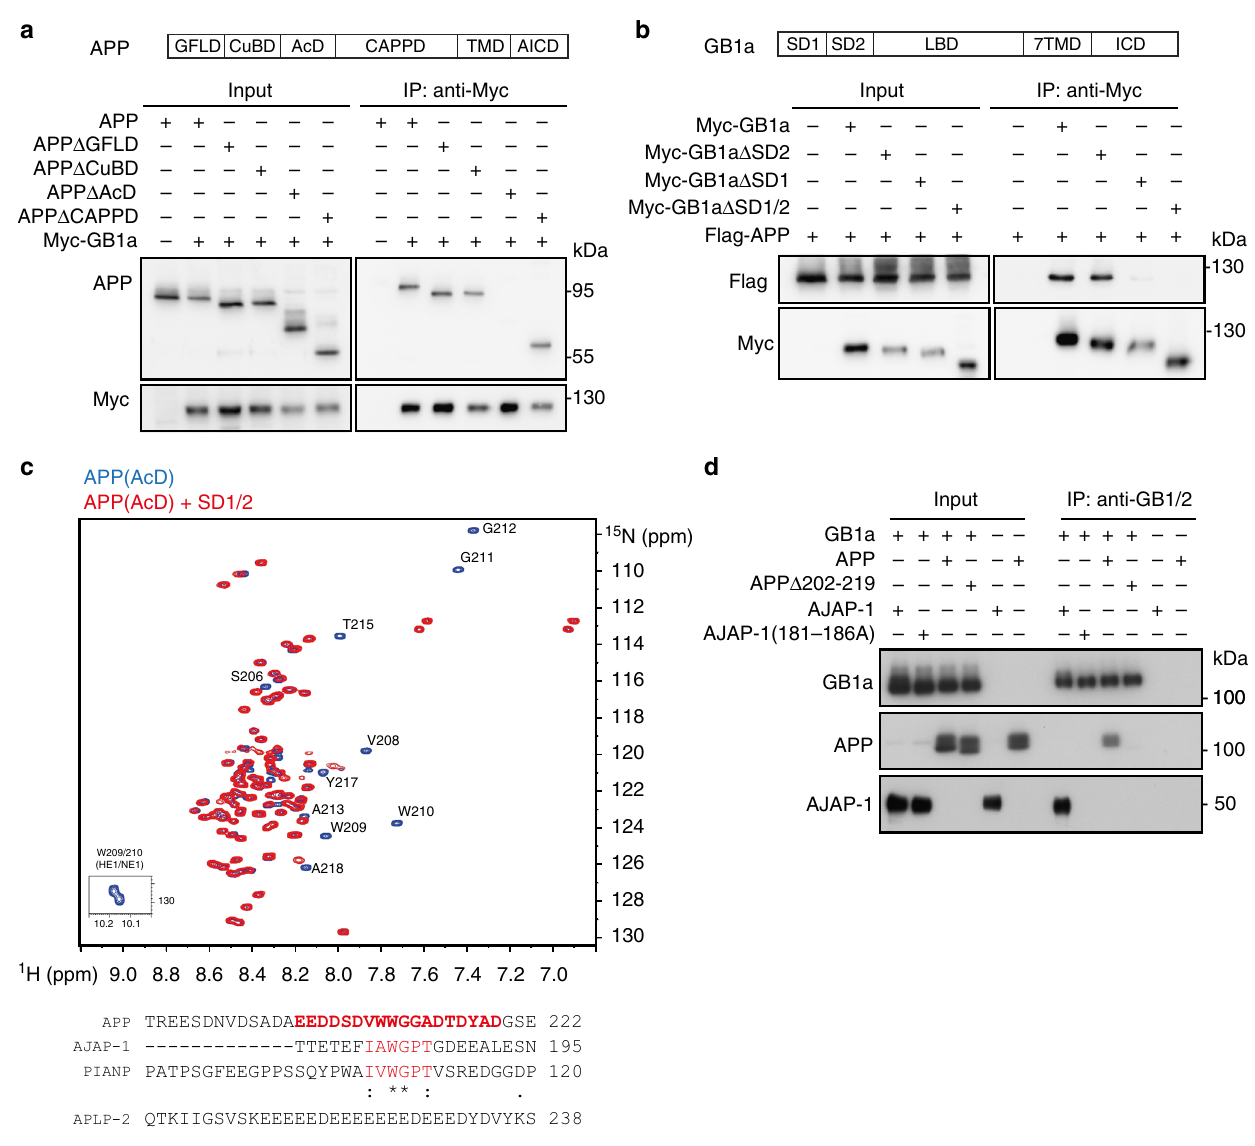
Fig. 2 Interacting epitopes of APP, AJAP-1 and PIANP with GB1a. a The acidic domain (AcD) of APP comprising amino acids 191 – 294 is necessary for GB1a binding. Immunoprecipitations using anti-Myc-antibodies from HEK293 cells expressing Myc-GB1a together with APP or APP deletion mutants. Abbreviations: GFLD, growth factor-like domain; CuBD, copper-binding domain; CAPPD, central APP domain; TMD, transmembrane domain; AICD, APP intracellular domain. b The N-terminal SD1 is necessary for binding of APP. Immunoprecipitations from HEK293 cells expressing Flag-APP together with GB1a deletion mutants lacking SD1, SD2 or both SD1/2. c The AcD of APP interacts with recombinant SD1/2 protein via amino acid residues 202 – 219 containing a WG sequence motif. Top: Two-dimensional 1 H – 15 N heteronuclear single quantum coherence (HSQC) spectra of 13 C/ 15 N labeled APP (AcD residues 191 – 294), alone (blue) or in complex (red) with unlabeled recombinant SD1/2. In complex with SD1/2 several APP residues exhibit chemical